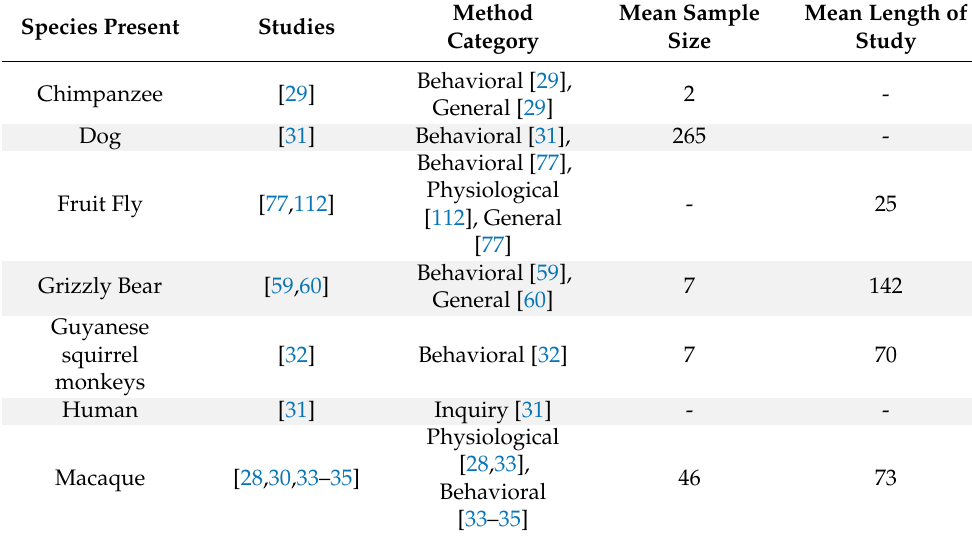
Table 1. Overview of the laboratory setting. The mean study length column represents the average time (in days) of study procedures. Shading added to aid